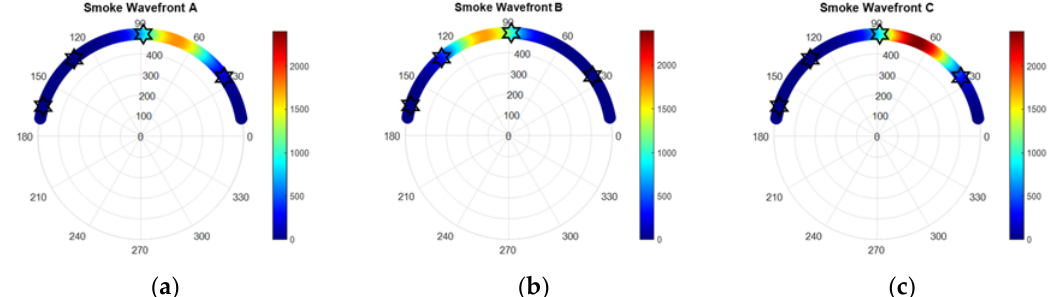
Figure 7. ( a ) Wavefront profile of smoke A modeled through Gaussian fit; ( b ) wavefront profile for smoke B; ( c ) wavefront profile for smoke C. Centers in the polar plots represent the center of the fire area and radius represent distances in meters. 90 degrees in polar coordinates represent the north. Symbols show measured data.